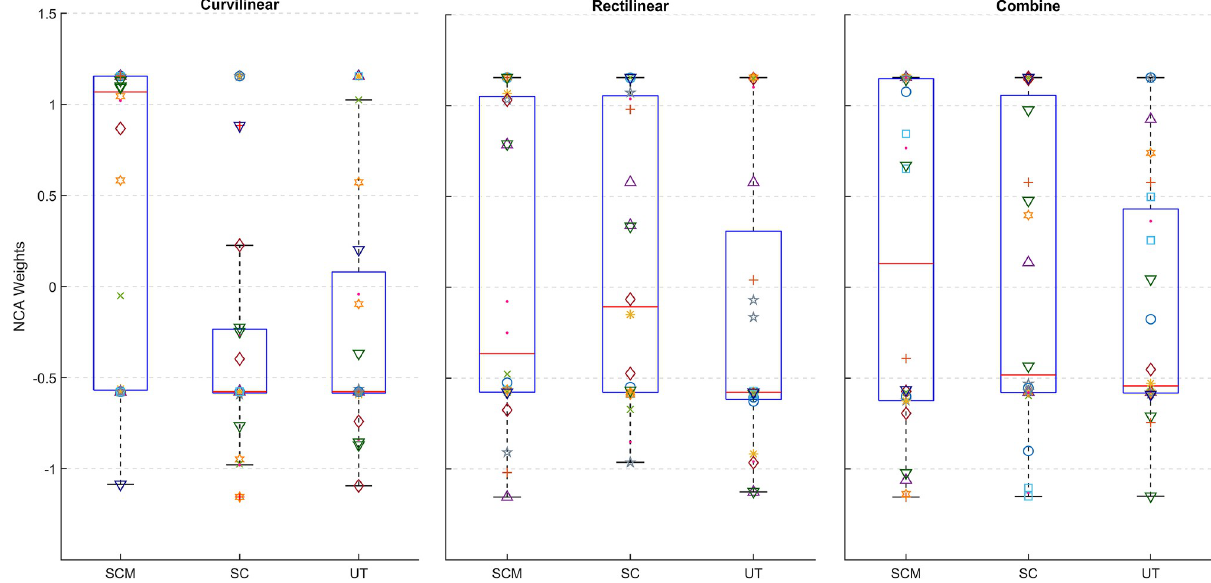
Fig 3. NCA weights of the features for each gait trajectory grouped by muscle. The higher the value, the more important it is. Weights from the left and right muscle are pooled.